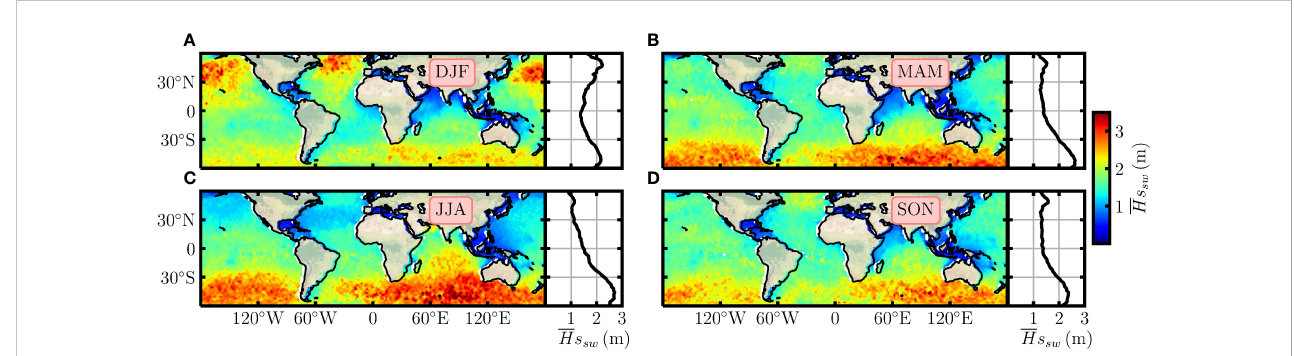
FIGURE 7 The global distributions of seasonal averaged (cid:1) Hs sw in (A) DJF, (B) MAM, (C) JJA, and (D) SON. The meridional variations are shown in the right